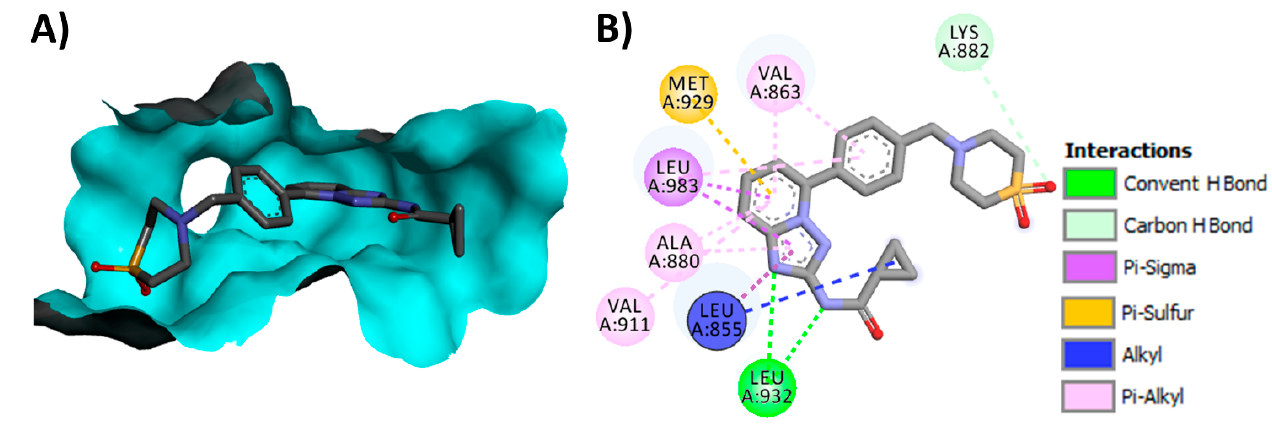
Figure 34. Binding modes of filgotinib (shown as sticks) into JAK1 (pdb: 4P7E): (A) 3D binding mode, receptor shown as a hydrogen bond surface; (B) 2D binding mode showing different types of interactions with JAK1; the figure was generated using Discovery Studio Visualizer (V16.1.0.15350).